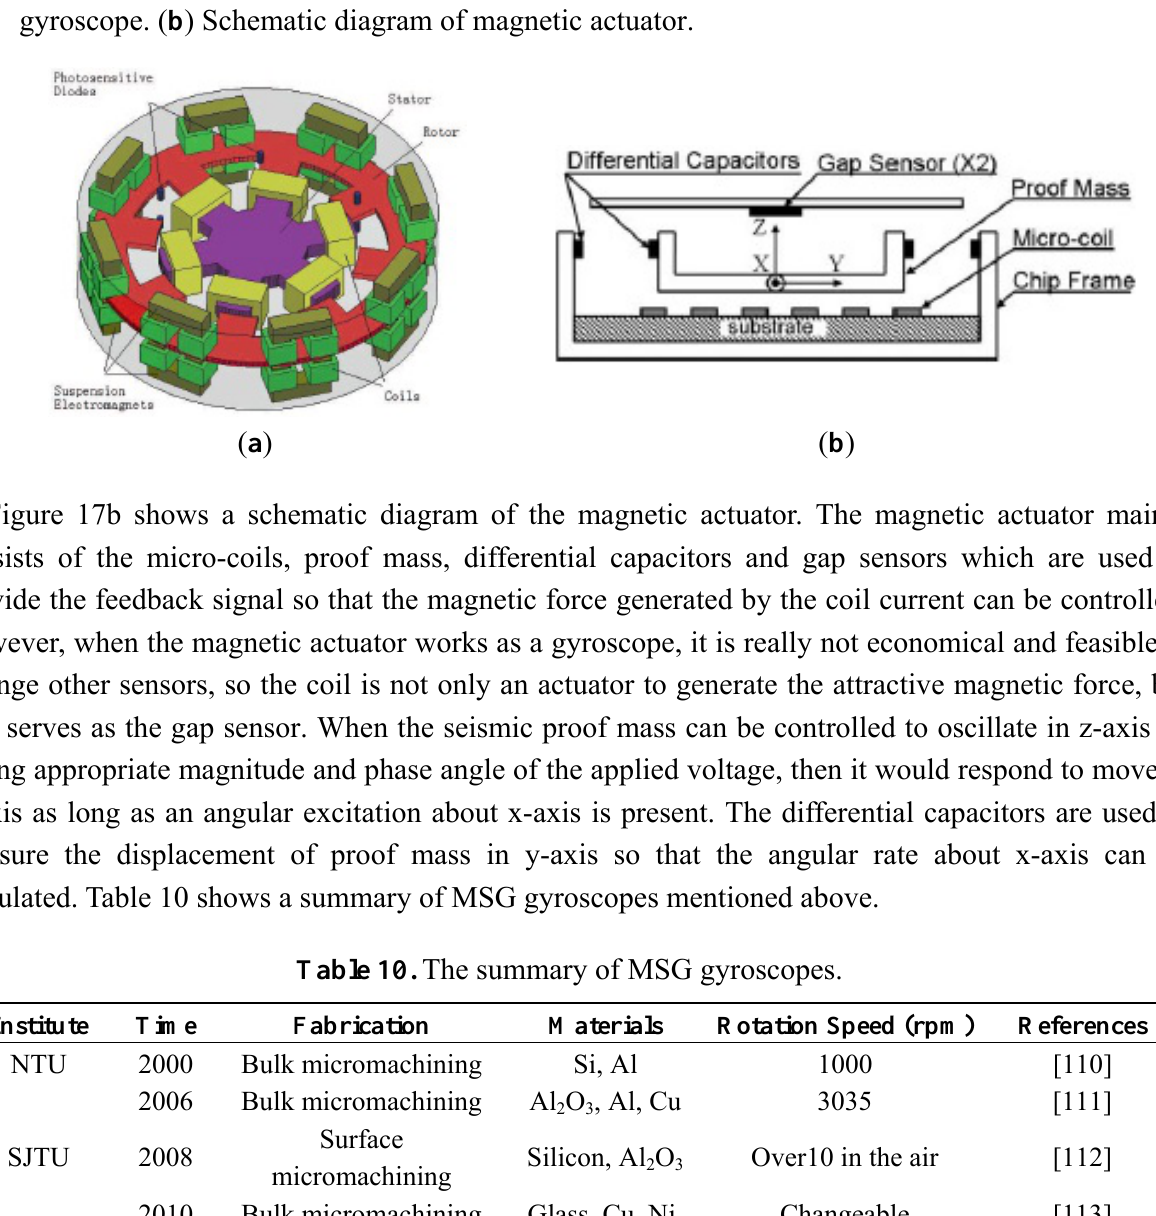
Figure 17. ( a ) University of Electronic Science and Technology suspended rotor gyroscope. ( b ) Schematic diagram of magnetic actuator.